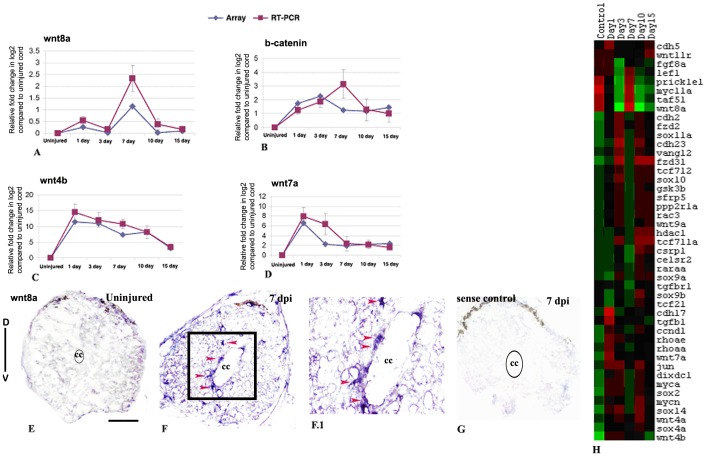
Differentially expressed genes involved in Wnt signaling pathway in zebrafish spinal cord after injury and validation of wnt8a, wnt4b, wnt7a and b- catenin:A–D) Quantitative RT-PCR analysis of wnt8a, b-catenin, wnt4b and wnt7a respectively showing fold change (red graph) and temporal expression pattern after injury. Pattern of expression was compared with microarray data (blue graph). Error bars represent SEM, n = 3, p<0.01. E–F) In situ hybridization with wnt8a anti-sense probe showed absence and presence of mRNA transcripts in uninjured and 7 dpi cord respectively. F.1) Higher magnification of the boxed area in section F shows wnt8a expression in ependymal cells (red arrowheads). G) In situ hybridization of 7 dpi section with wnt8asense probe as control. ‘D’ and ‘V’ indicates dorsal and ventral side of the cord respectively. The mark ‘cc’ denotes central canal of the cord. H) Represents temporal expression pattern of genes after SCI related to Wnt signaling pathway. The color chart indicates mean fold change of gene expression in each time points. Red and green colors represent increased and decreased expression respectively. Scale bar = 50 µm.